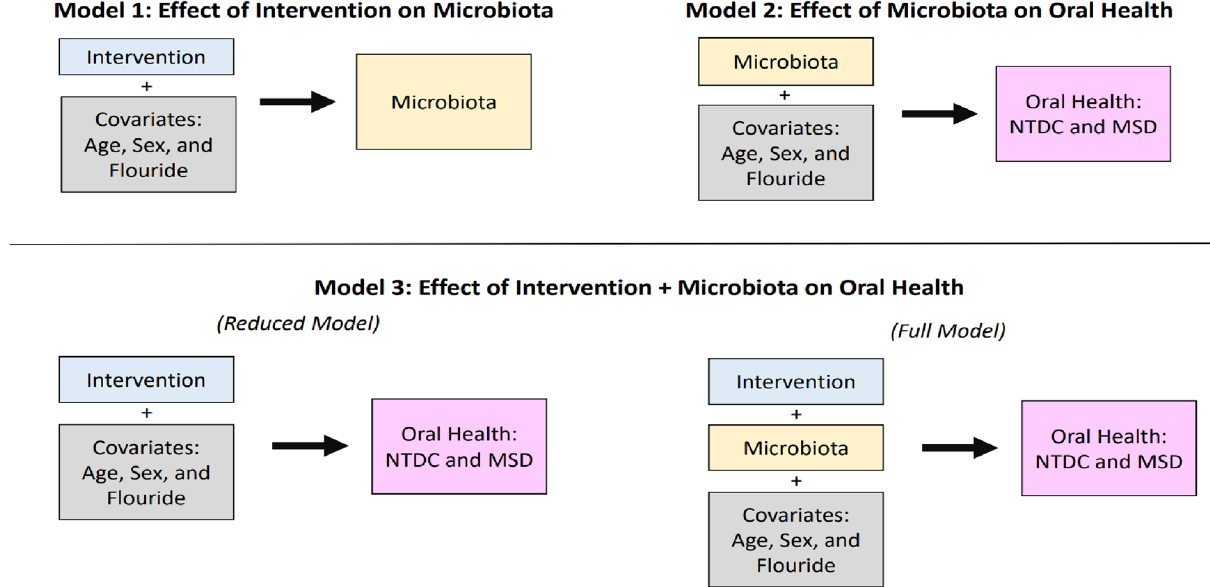
Figure 1. Statistical models used to analyze the interactions between intervention, the microbiota and oral (i.e. dental) health. The rectangles on the left- or right-hand side of the arrows represent groups of variables designated as either predictors (x) or response variables (y), respectively, in a linear regression model. Model 3 is evaluated by fitting the reduced and full model separately, then comparing them to determine whether inclusion of the microbiota improved the prediction of oral health. NTDC, number of dentin caries. MSD, most severe